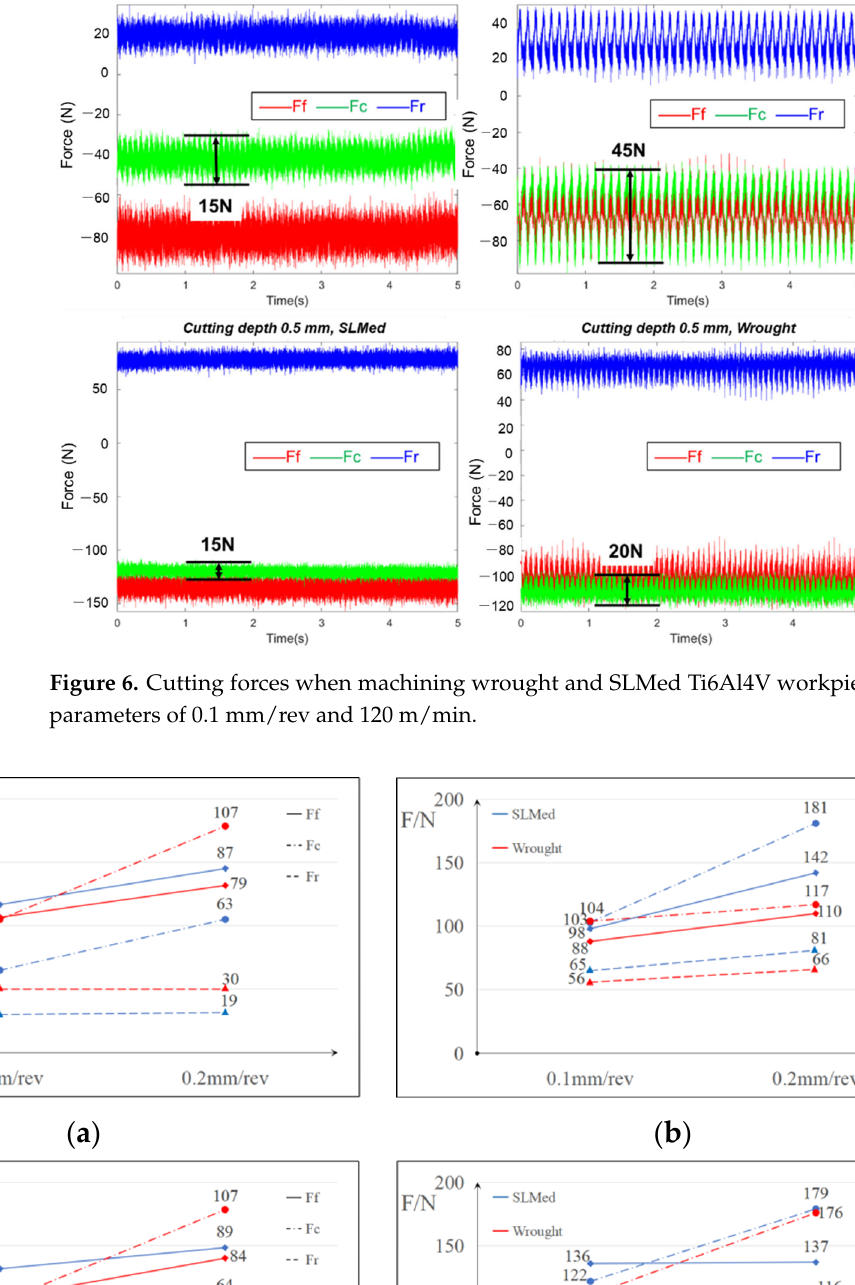
Figure 7. Average values of the three ‐ axis cutting forces at different cutting parameters: ( a ) cutting depth 0.25 mm, cutting speed 80 m/min, ( b ) cutting depth 0.25 mm, cutting speed 120 m/min, ( c ) cutting depth 0.5 mm, cutting speed 80 m/min, ( d ) cutting depth 0.5 mm, cutting speed 120 m/min.